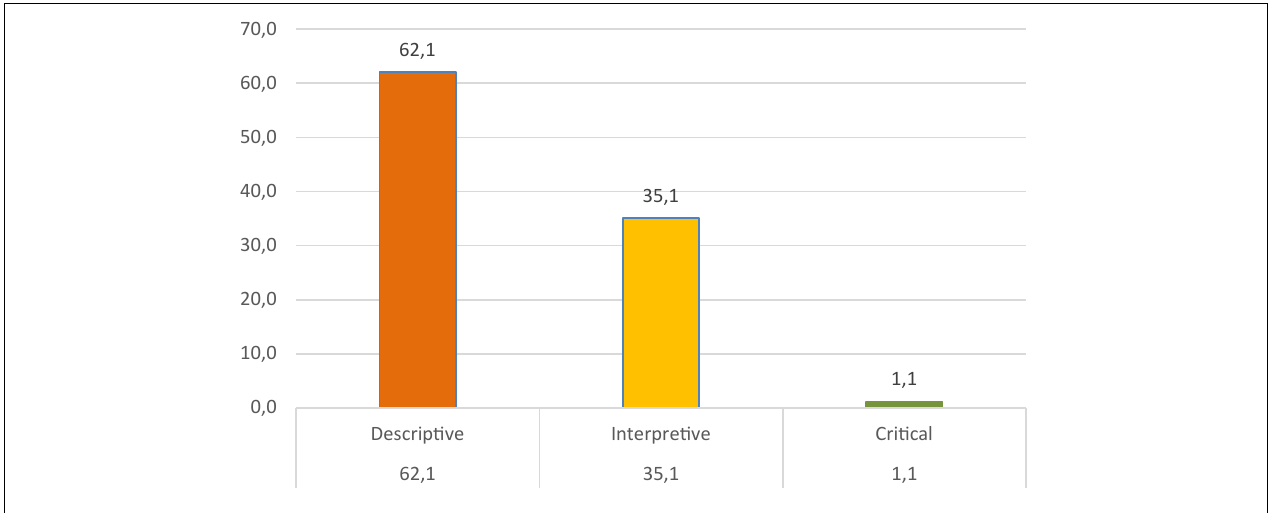
FIGURE 4 | Percentage of descriptive, interpretive, and critical answers, per